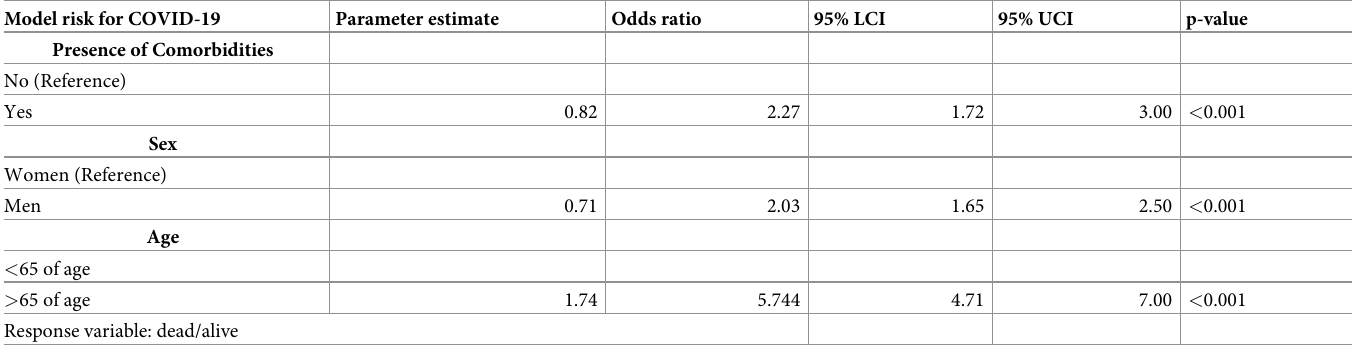
We found an 11-day lag (IQR: 7–15 days) between COVID-19 cases symptoms onset and the reported number of COVID-19 related deaths (S4 Fig). Basic reproduction number (R0). We calculated the basic reproduction number (R0) for the entire country using the exponential growth criteria. During the first months of the pan- demic while numbers were increasing exponentially, the R0 was found to be 3.54 (CI: 3.46– 3.63). When computing the R0 by provinces, we found R0 values as high as 3.68 (CI: 3.18– 4.28) in Los Rios, followed by 3.68 (CI: 2.53–5.28) in Esmeraldas and 3.67 (CI: 3.56–3.78) in